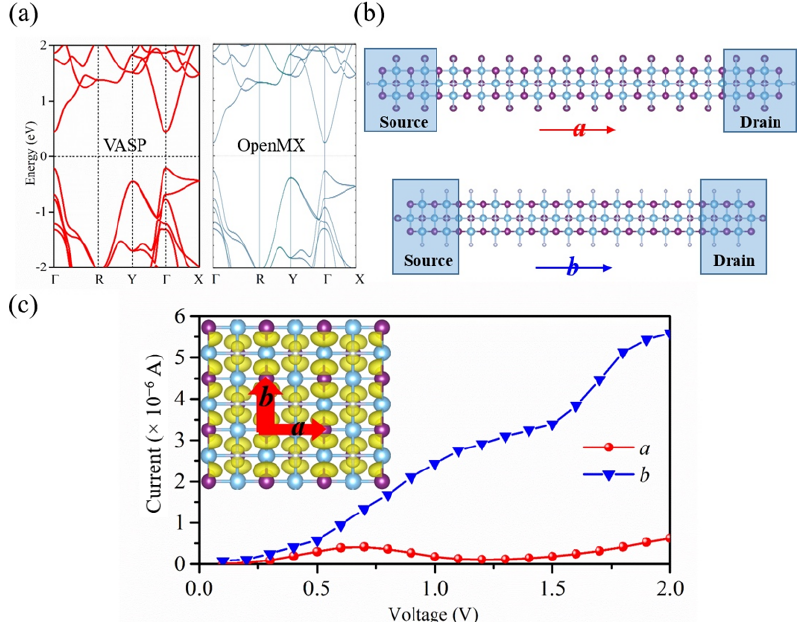
Figure 5. ( a ) The energy band of single − layer TiNI calculated by VASP shows on left side and the energy band of single − layer TiNI calculated by OpenMX shows on right side ( b ) Above and below are schematic diagrams of conveying device in a -direction and b -direction, respectively. ( c ) Voltammetric curves toward the a -direction and the b -direction, with illustrations of local charge densities near Fermi surfaces.